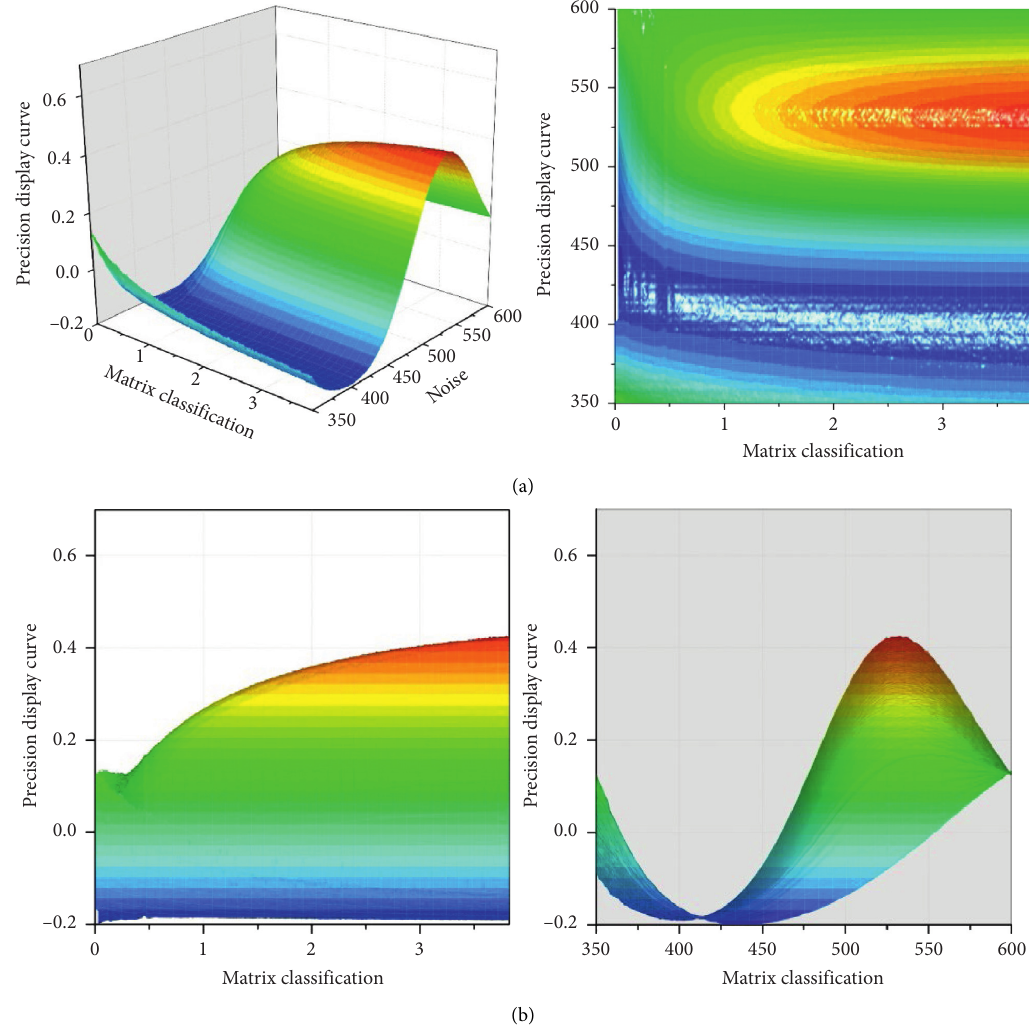
Figure 9: The result of learning from simulation data: (a) raw data matrix and (b) classification accuracy